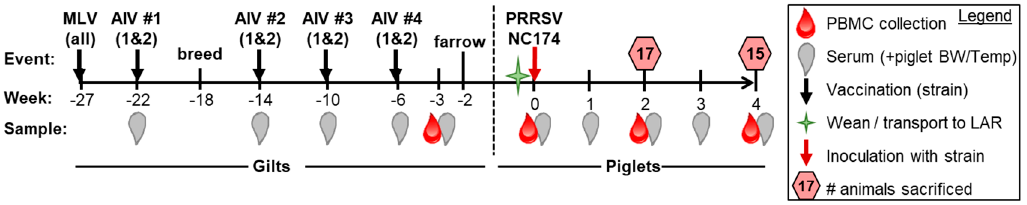
Figure 1. Study design: The study included gilts that were either vaccinated with a modified live vaccine only (MLV, treatment (TRT) 0), or an MLV boosted by a series of four vaccinations using one of two autogenous inactivated virus (AIV) vaccines (TRT 1+2). One week before farrowing, blood from gilts was collected to assess the systemic humoral and cell-mediated adaptive immune response. Piglets from three gilts with high humoral and T-cell responses within each treatment group (TRT 0, 1, 2) were included in the second part of the study—the challenge part at the North Carolina (NC) State Laboratory Animal Resources (LAR). These piglets were intranasally inoculated with the autogenous PRRSV 1-7-4 strain at two weeks of age (0 weeks post inoculation, wpi). Pigs were also bled, as illustrated, to assess the immune response to Porcine Reproductive and Respiratory Syndrome Virus (PRRSV). To assess lung pathology and study the local immune response, half of the pigs were sacrificed at 2 wpi and half at 4 wpi. PBMC: peripheral blood mononuclear cells.